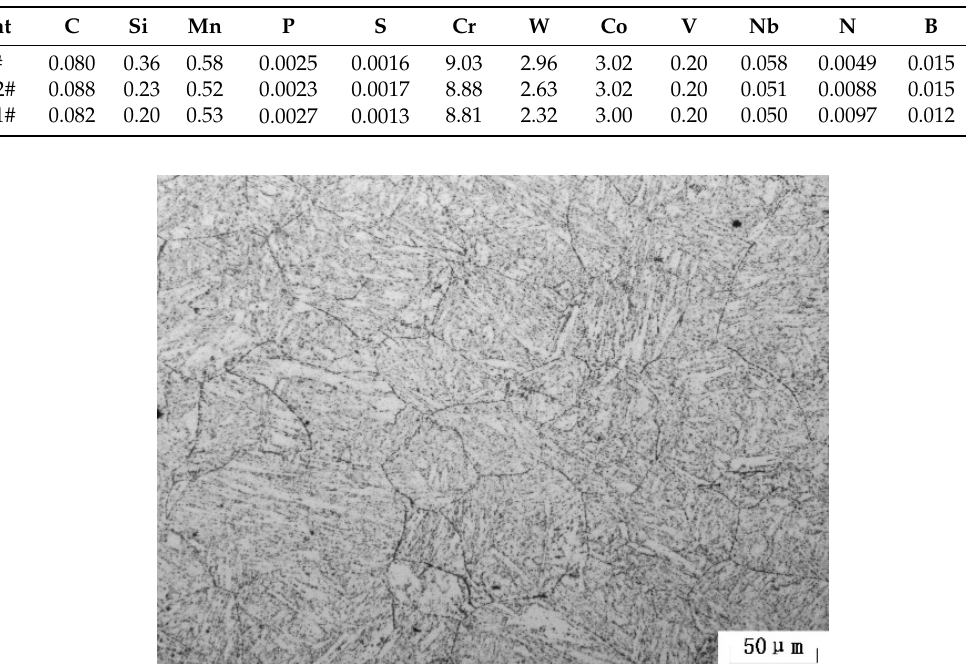
Table 1. Chemical compositions of the steels studied (mass %).